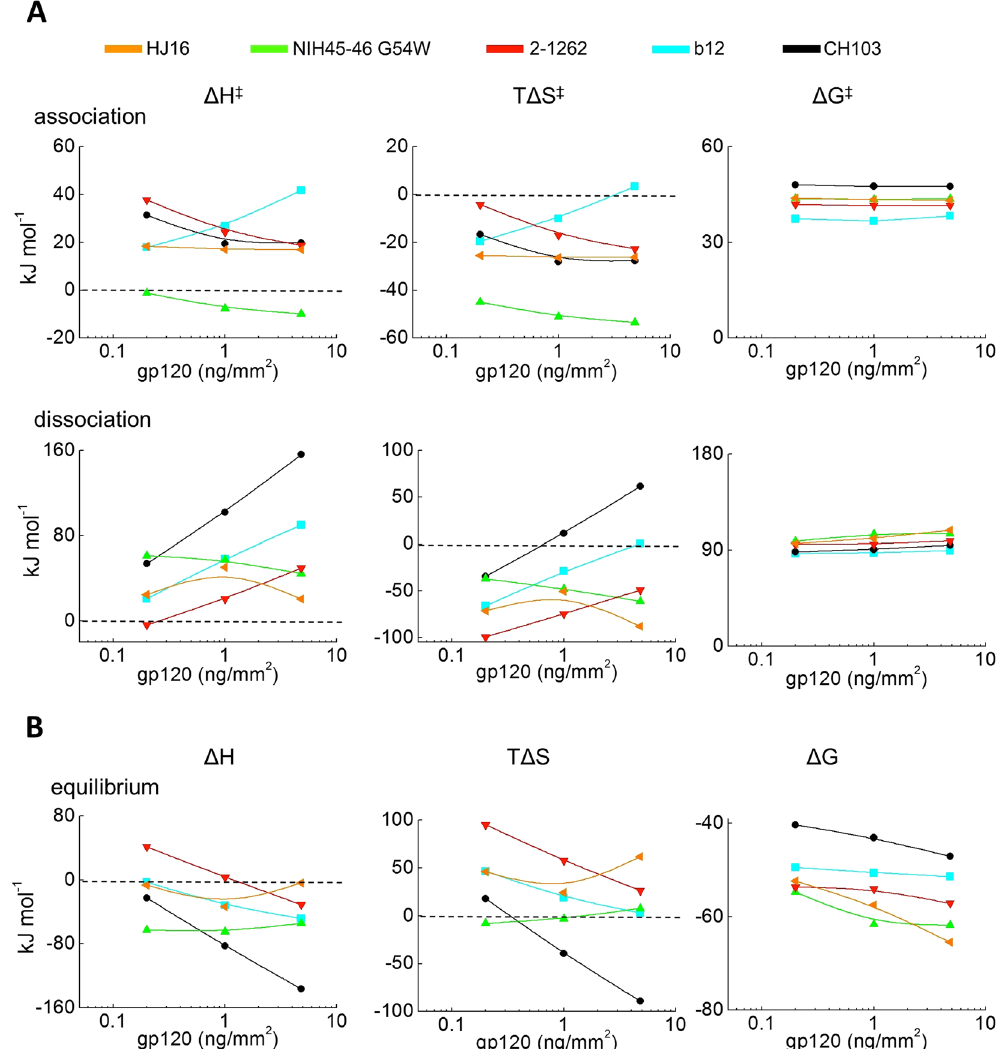
Figure 5. ( A ) Effect of density of surface-bound antigen on the activation thermodynamics of gp120 CD4- binding site specific Abs. Changes of thermodynamic parameters of HJ16 (orange line and symbols), NIH45- 46 G54W (green line and symbols), 2-1262 (red line and symbols), b12 (blue line and symbols) and CH103 (black line and symbols) as a function of surface density of gp120 CN54 are presented. The values of the thermodynamic parameters were calculated by Eyring’s analyses using slopes of Arrhenius plots depicted on Fig. 4. All thermodynamic parameters were calculated at a reference temperature of 25 °C (293.7 K). ( B ) Effect of density of surface-bound antigen on the equilibrium thermodynamics of CD4 binding site-specific Abs. The values of the thermodynamic parameters were evaluated as described in the experimental procedures. All equilibrium thermodynamic parameters were calculated at a reference temperature of 25 °C (293.7